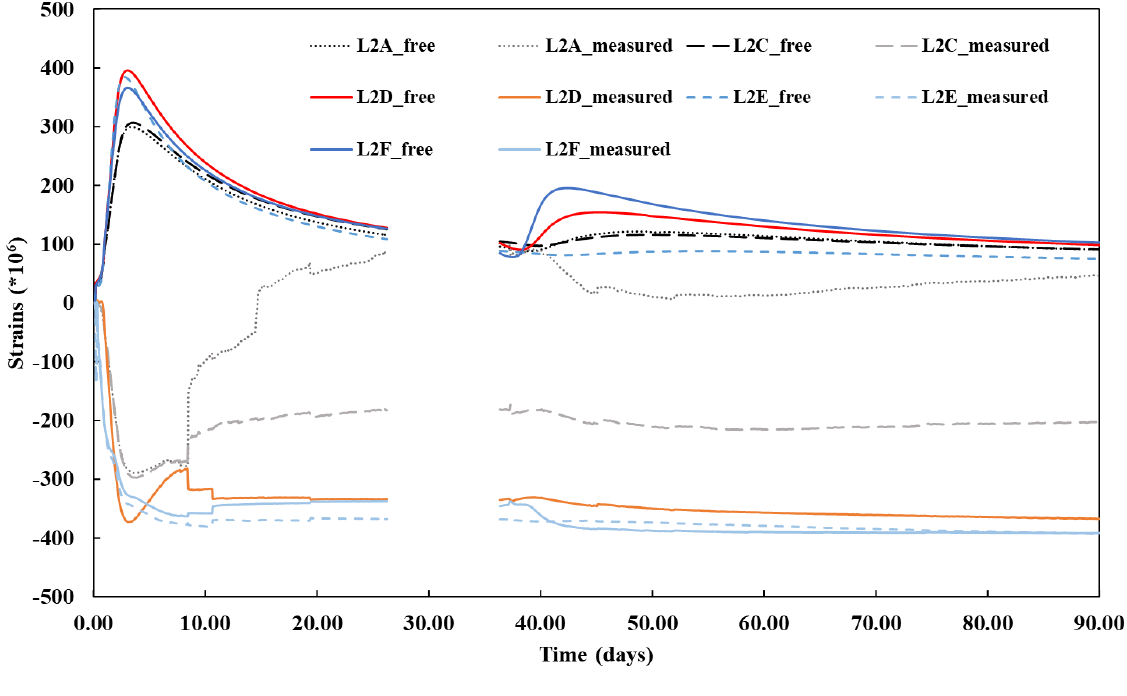
Figure 7: Free thermal strains and measured strains in time for L2.